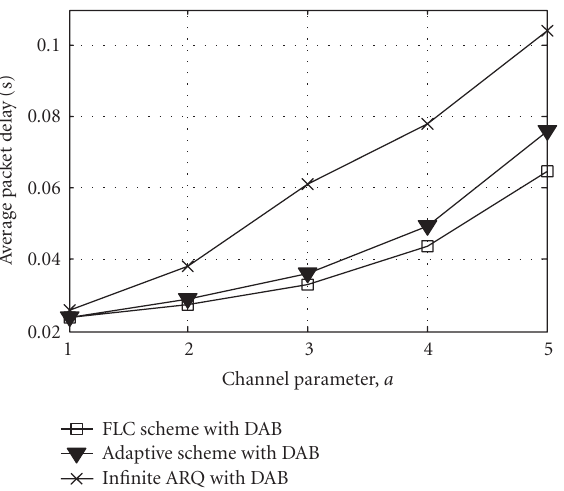
Figure 8: Mean PSNR for three DAB-based schemes, with changing bu ff er size.